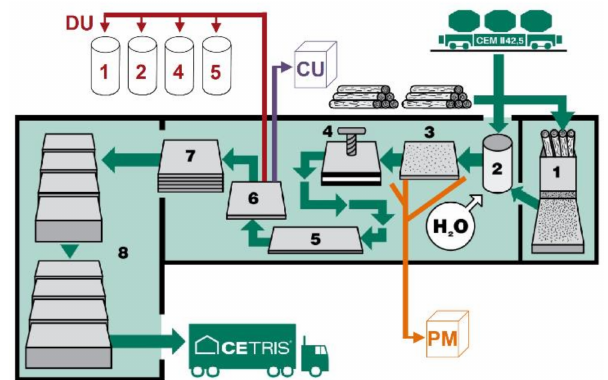
Figure 4. Production flow-chart of CIDEM Hranice, a.s cement-bonded particleboard: 1—spilling; 2—preparation of mixture; 3—layering of boards; 4—pressing; 5—drying; 6—formatting; 7—storage; 8—transport (red DU 1, 2, 4, 5—silos for collecting the dust; violet CU—covered space for collect- ing cuttings from formatting particleboards; orange PM—covered space for storing the particle mixture)